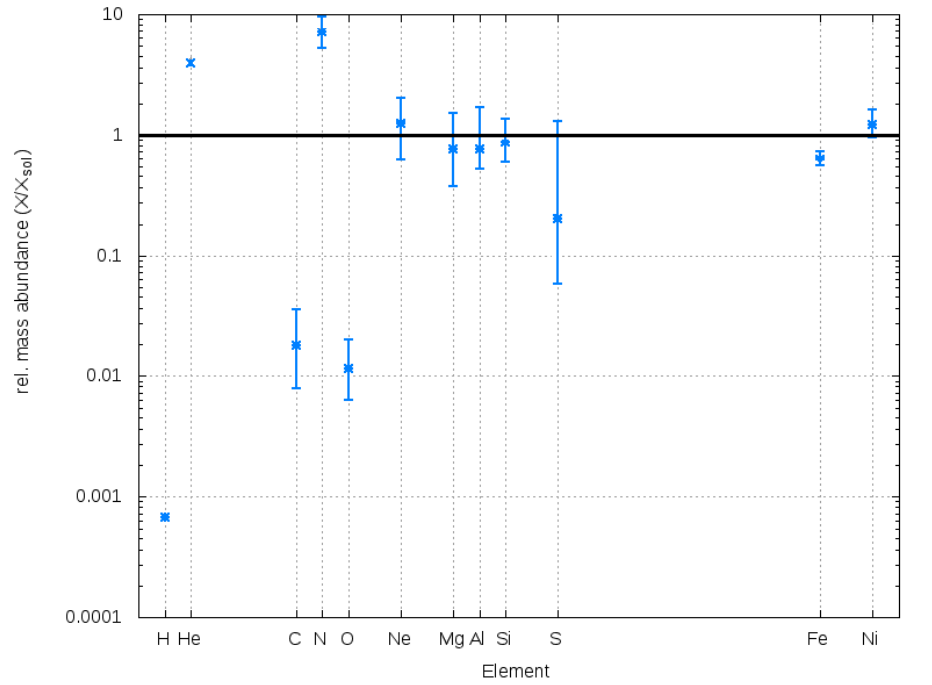
Figure 3. Abundance pattern of CD-31 ∘ 4800. Given is the relative mass abundance compared to the sun. The solar value is indicated by the black